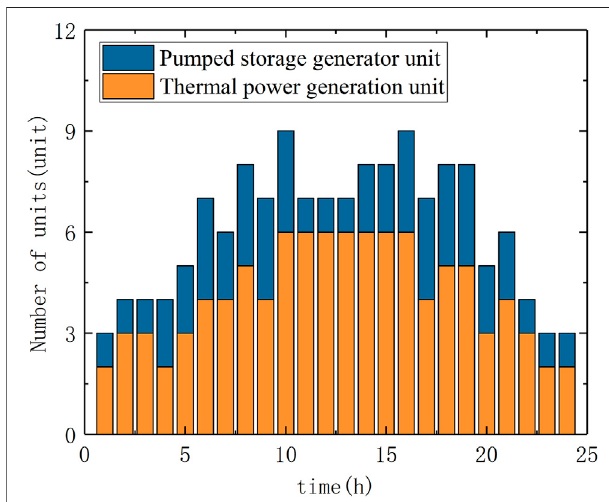
FIGURE 5 | Peak shaving operation status of the pumped storage unit and thermal power unit at each moment.